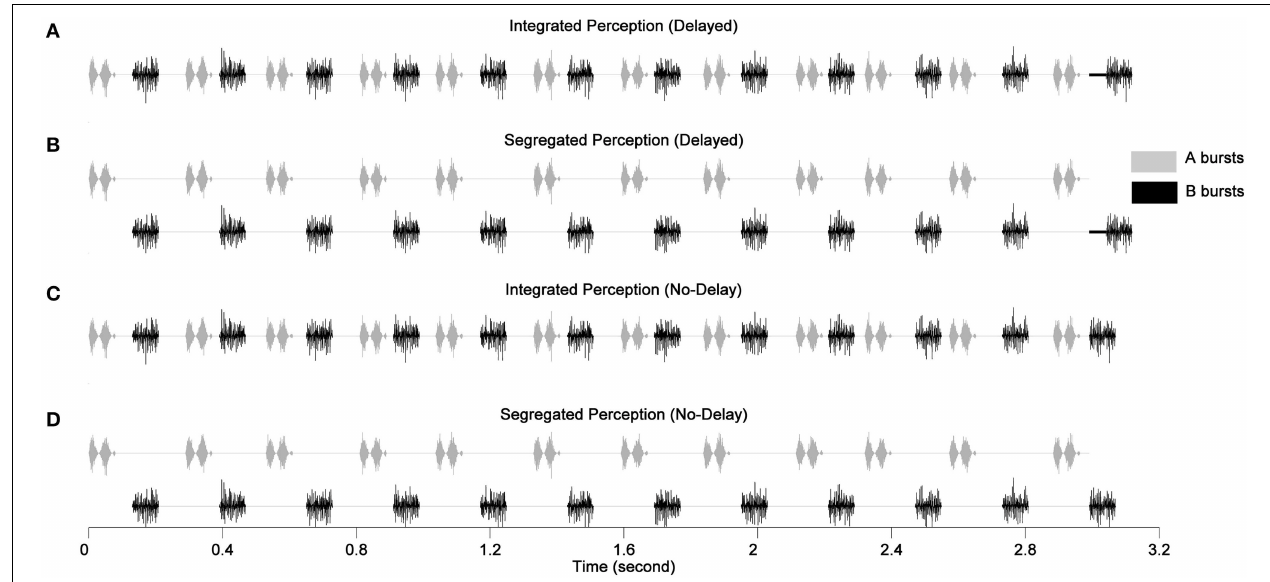
FIGURE 1 | Illustration of the stimulus paradigm (modified from Nie et al., 2014). (A,B) Illustrate the delayed sequences with the dark solid lines showing the duration of the delay for the last B burst. (C,D) Illustrate the no-delay sequences. (A,C) Depict the